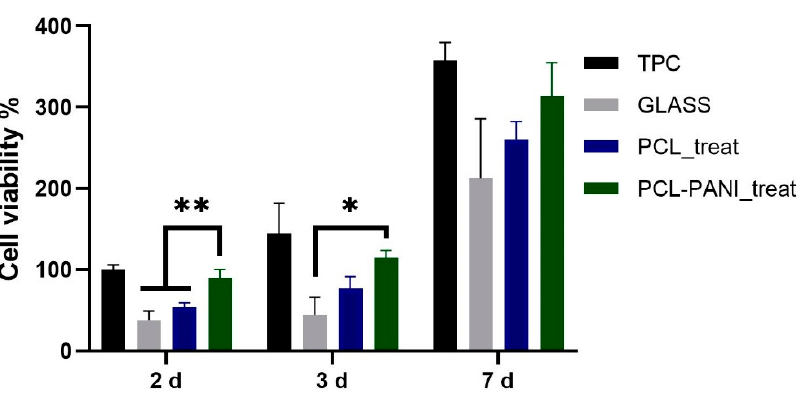
Figure 8. Evaluation of HFF-1 viability on different substrates after 2, 3 and 7 days of culture. Statistical difference (* p < 0.05; ** p < 0.005).